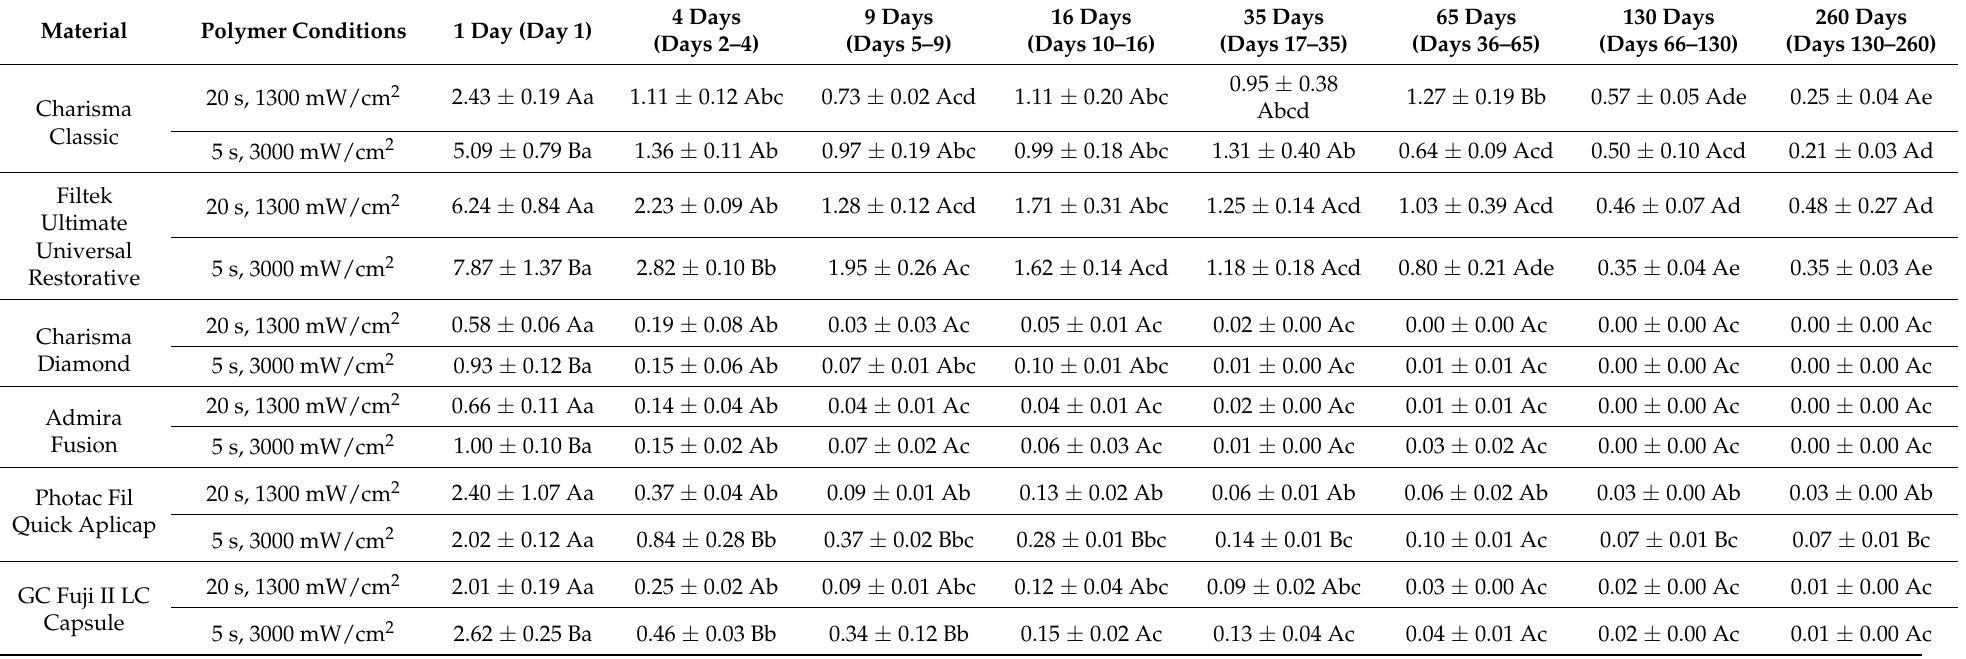
Table 2. Average daily release of BPA in the artificial saliva per gram of material (mean ± SD in